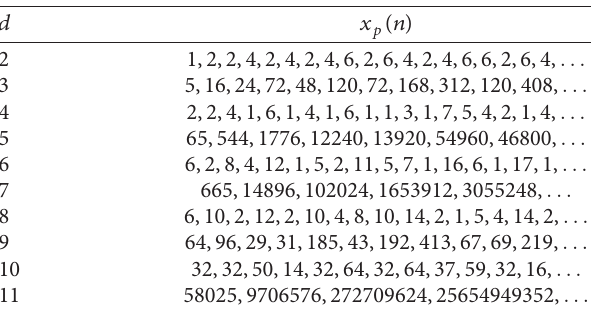
Table 2: Sequences of first-order differences of consecutive d -primes, given by x d ∈ 2 , 3 , .. . , 11 { }